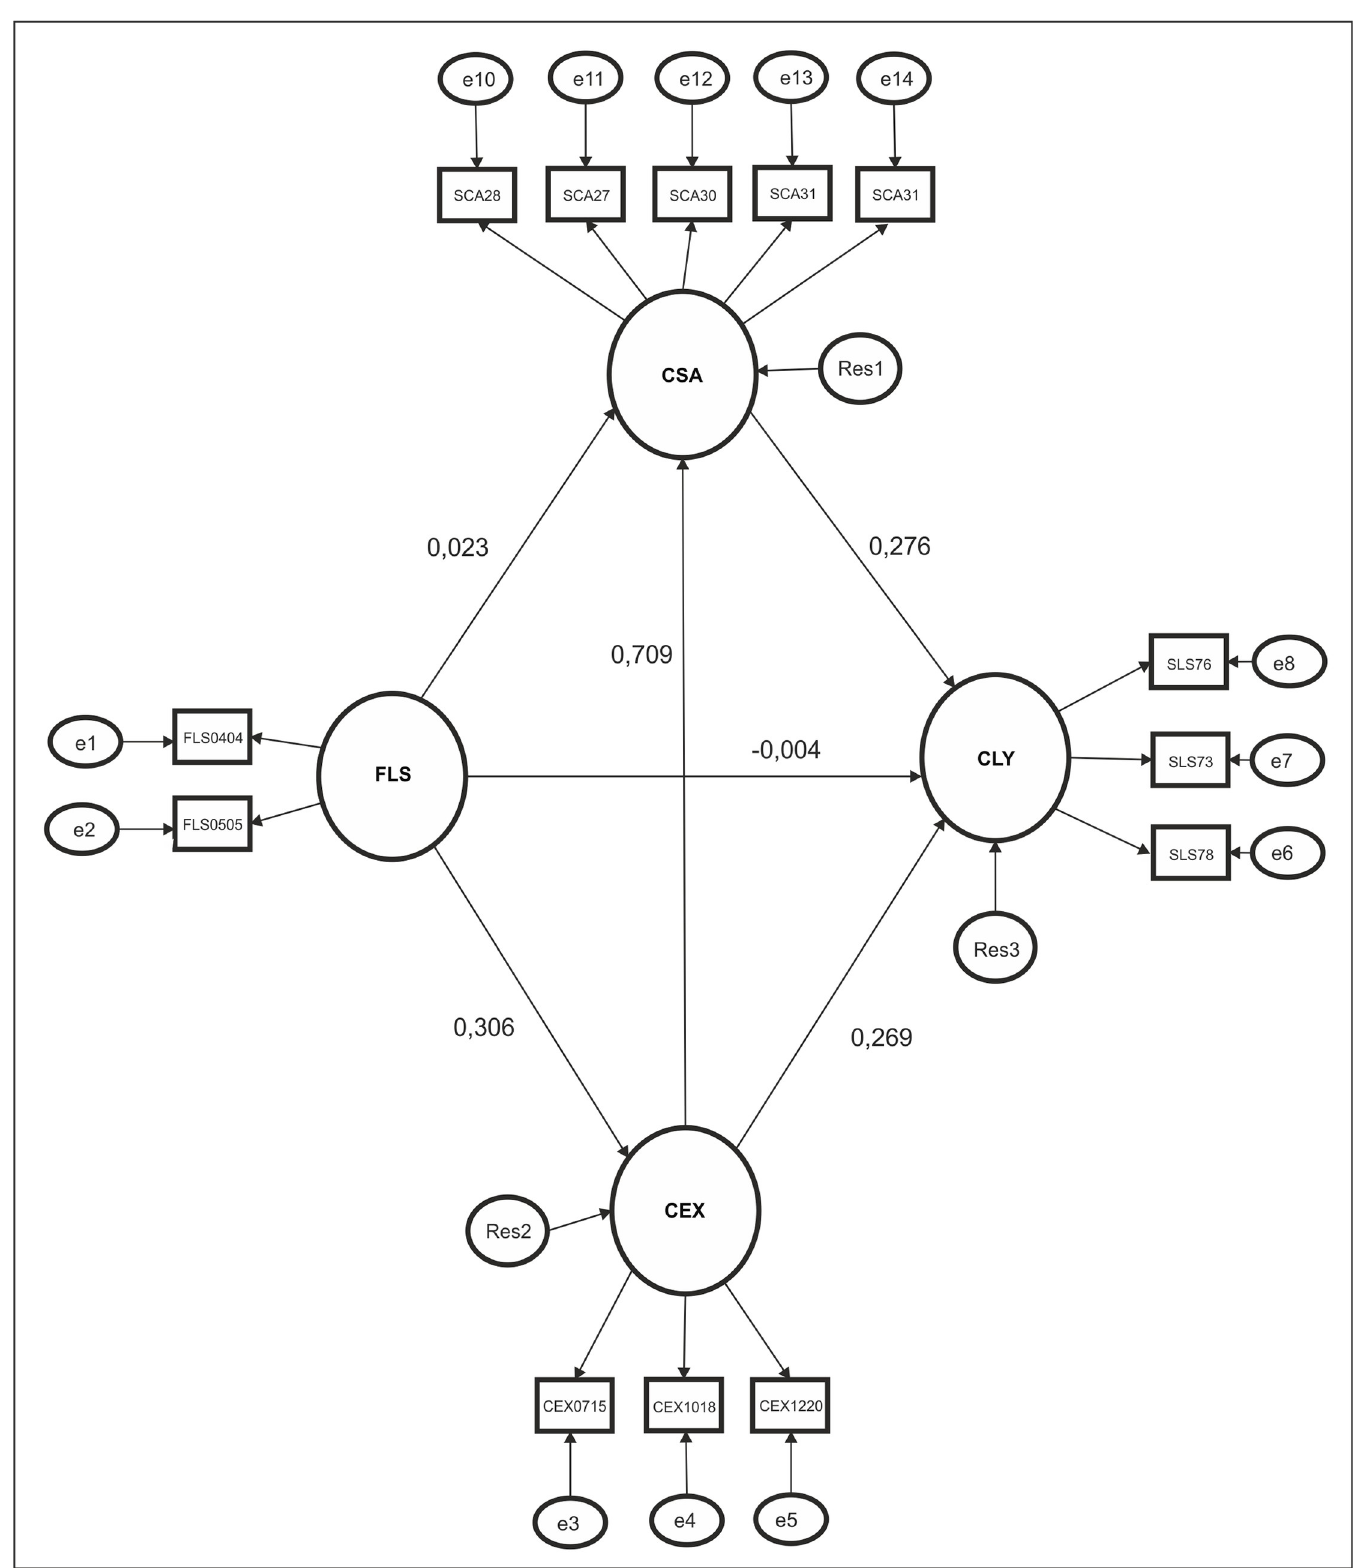
Fig 2. Results of the SEM